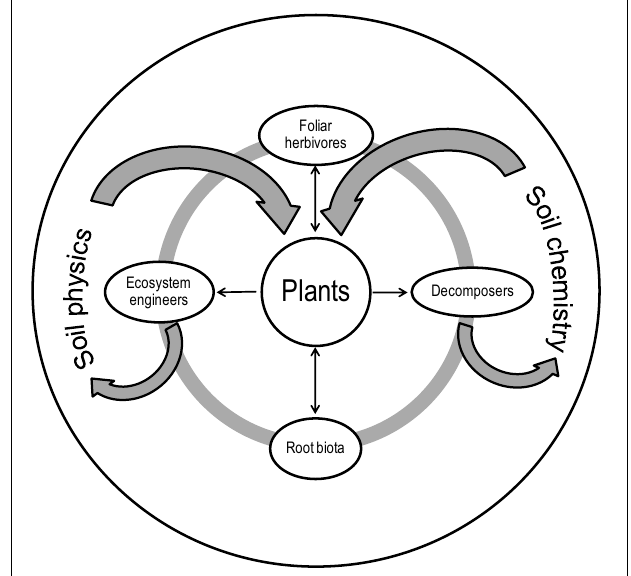
FIGURE 3 | “Plant-centric framework” (redrawn from Brussaard, 1998, with permission from Elsevier).